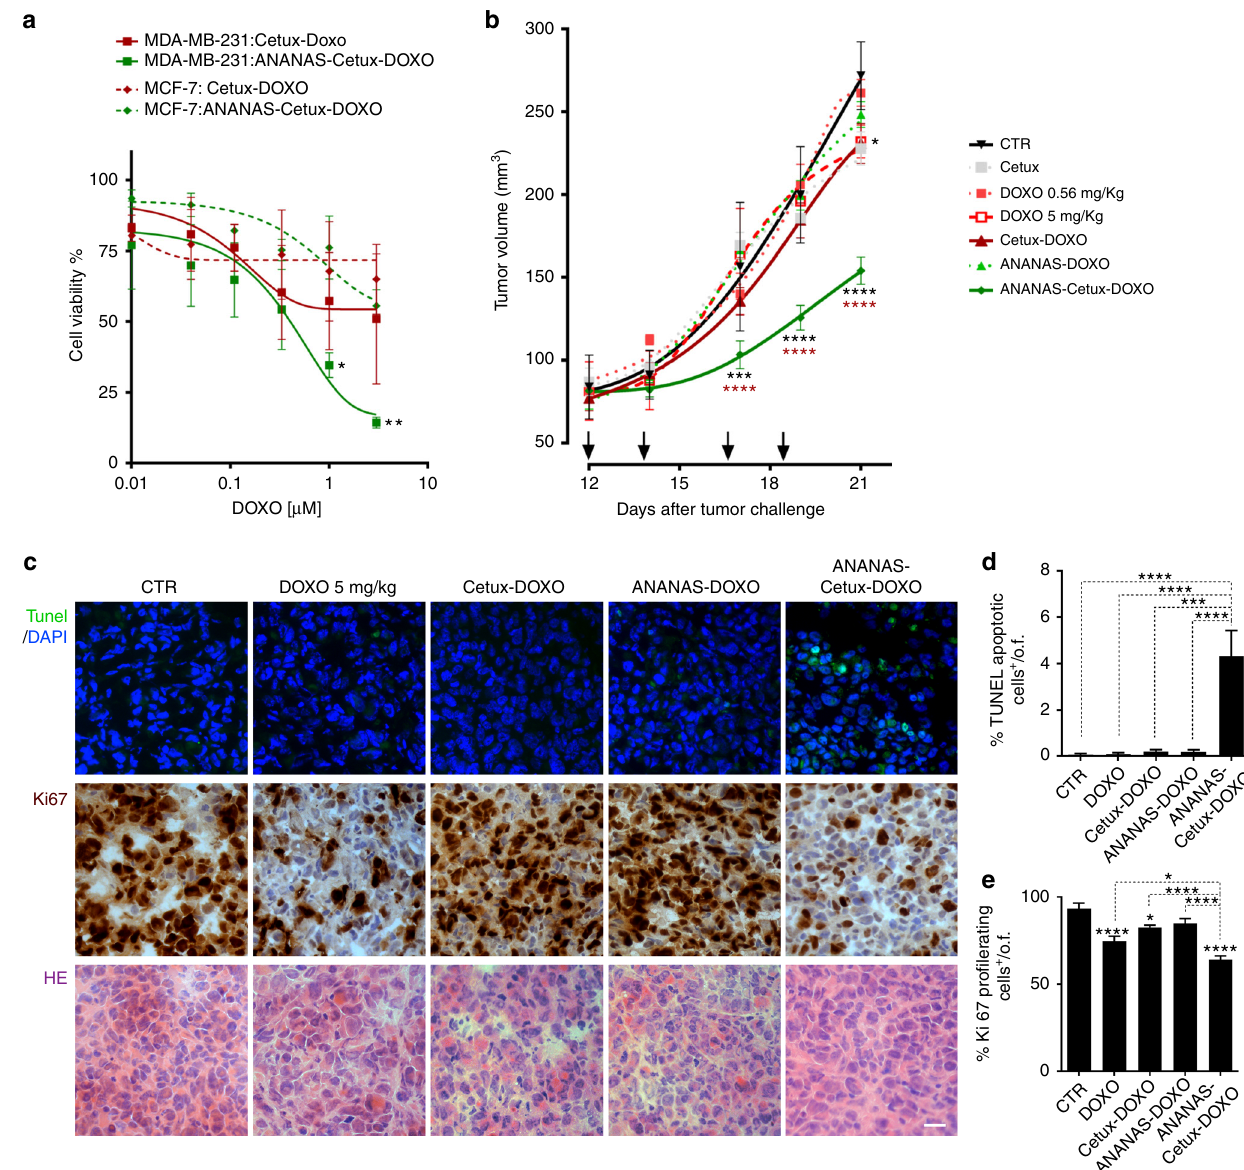
Fig. 6 In vitro and in vivo activity of doxorubicin carrying formulations. a Cell viability was assessed in MCF-7 and MDA-MB-231 cell lines after 6 h treatment and wash out for following 72 h (MTT test). Data presented as mean of n = 2 experiments ± SEM (paired t student) * p < 0.05, ** p < 0.01; b . Tumor volume measured in xenografts of MDA-MB-231 cells injected subcutaneously in the fl ank of NOD/SCID mice ( n = 6/group). Animals were treated four times (as indicated by the arrows) with the different doxorubicin containing formulations (doxorubicin low = 0.56 mg/kg), free cetuximab (same dosage as in ANANAS-doxo-cetux10, corresponding to 2.8 mg/kg — 0.92 mg/m 2 — in cetuximab) or doxorubicin high dose (5 mg/kg) by i.v. injection, and killed at day 21. Data are presented as mean ± SEM (two-way ANOVA ANANAS-cetux-doxo against ctrl: black — upper asterisks or against cetux-doxo: brown - lower asterisks): * p < 0.05, ** p < 0.01, *** p < 0.001, **** p < 0.0001. c Histological analyses of excised tumors, stained for TUNEL, Ki67, and hematoxylin/eosin (HE). × 40 magni fi cation, size bar = 25 µ m. d , e TUNEL and Ki67 quanti fi cation represented as the percentage of positive-cells over the total number of nuclei per optical fi eld (o.f.). Data are presented as mean ± SEM (paired t test) * p < 0.05, ** p < 0.01, *** p < 0.001, **** p < Methods Reagents and instrumentation . Biotin-hydrazide (Ez-Link TM , Thermo Scienti fi c, 21339); biotin-PEG 5KDa -SVA (biotin-PEG-SVA) and biotin-(PEG 5KDa )-NH 2 (biotin-PEG - NH 2 ) were from Laysan Bio (Huntsville, AL, USA); Atto488 N - hydroxysuccinimidylester (Atto488-NHS, ATTO-TEC, gmbh, AD 488-3, Siegen, Germany); Cetuximab (Erbitux ® , MerckSerono, 5mg/mL). Absolute ethanol, die- thyl ether (Et 2 O), and glacial acetic (AcOH) acid were from Carlo Erba reagents, (Italy). Ethyl acetate (EtOAc) AnalaR Normapur was supplied from WVR (Radnor, Pennsylvania, US). Ninhydrin (cat no. 415720750) and triethylamine (TEA, cat no. 15791) were obtained from Acros Organics); NHS was from ABCR, cat. no. AB110699); 2-(4-hydroxyphenylazo)benzoic acid (cat. no. 54793) and N , N ’ -dicy- clohexylcarbodiimide (DCCI, cat. no. 36650), tert -butyl carbazate (BOC-Hz, cat no.